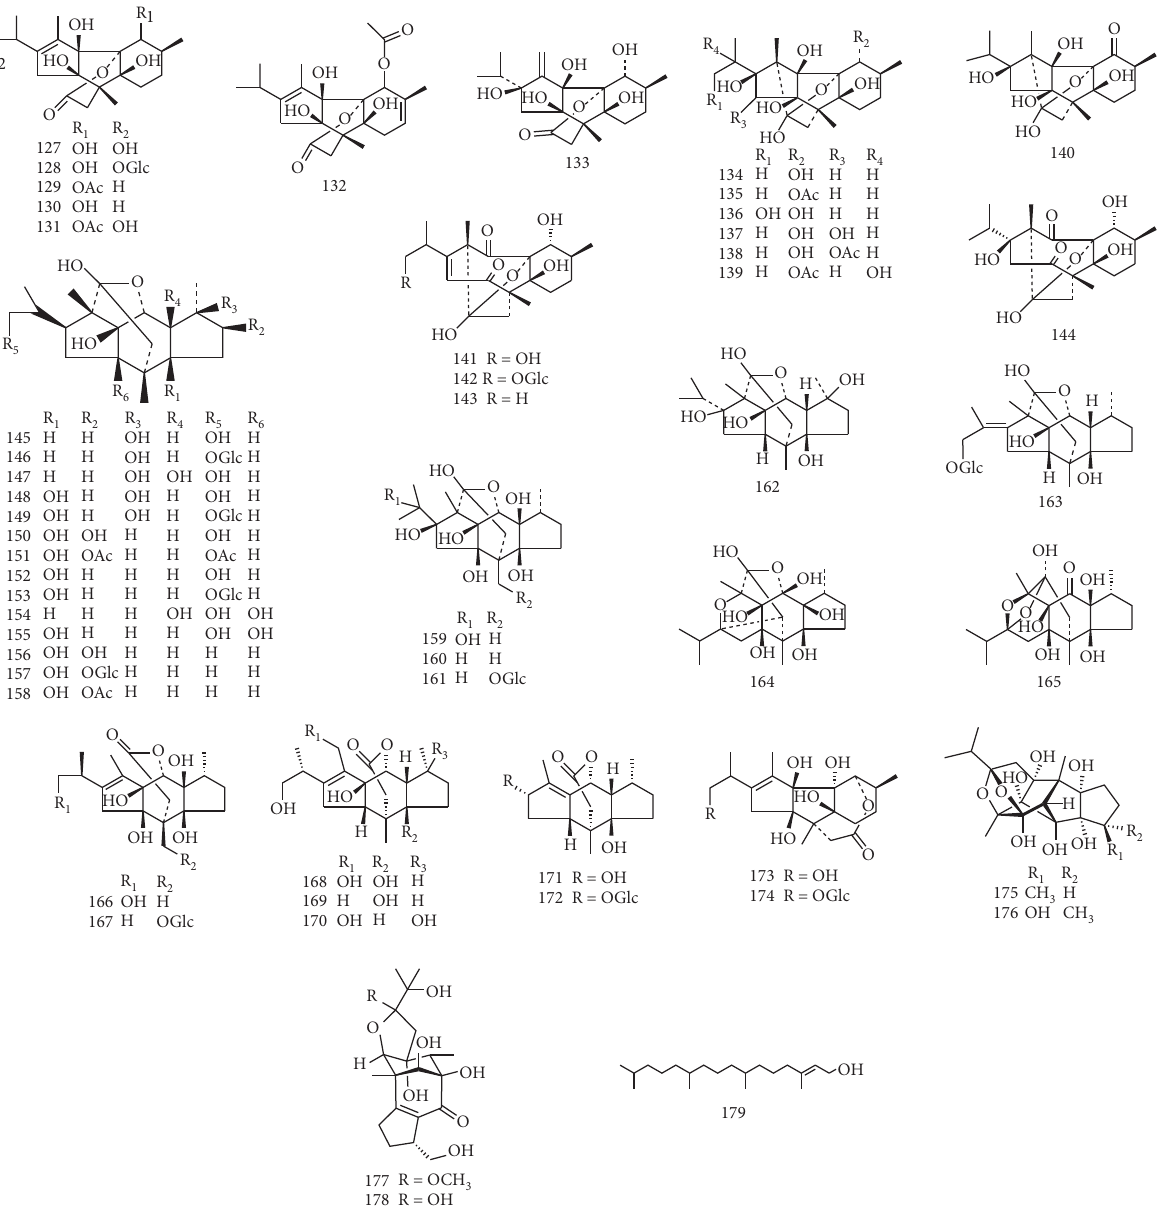
Figure 3: The structures of diterpenes from Cinnamomum